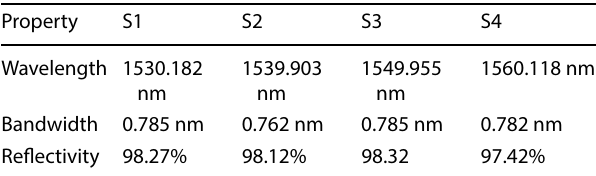
Table 1 Properties of the grating sensors S1, S2, S3 and S4 (DK Pho- tonics) Property